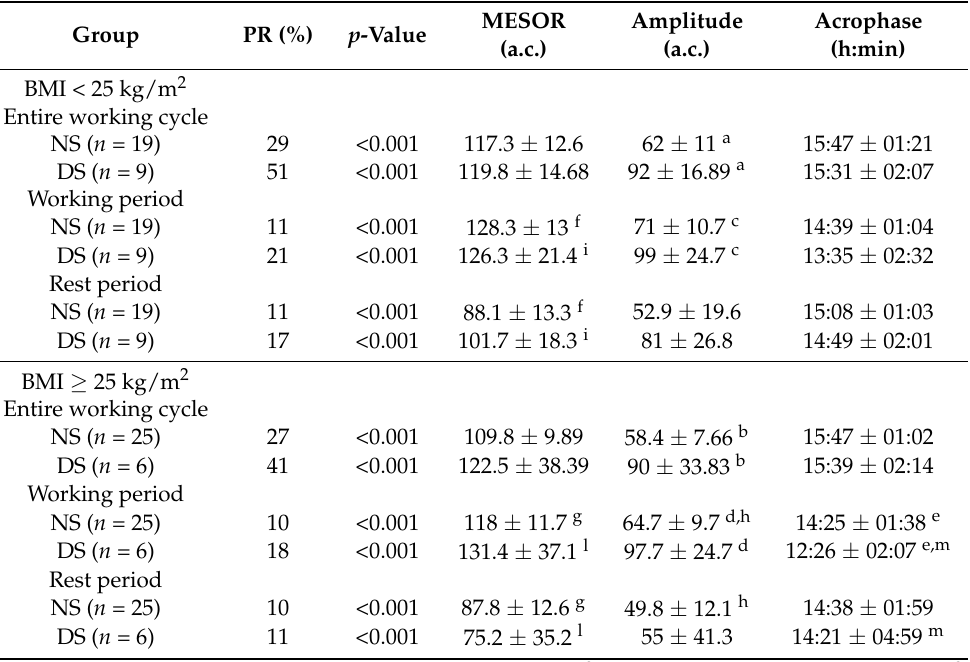
Table 2. Population mean cosinor analysis in normal weight and overweight nurses in relation to work shift during the entire working cycle, the working period and the rest